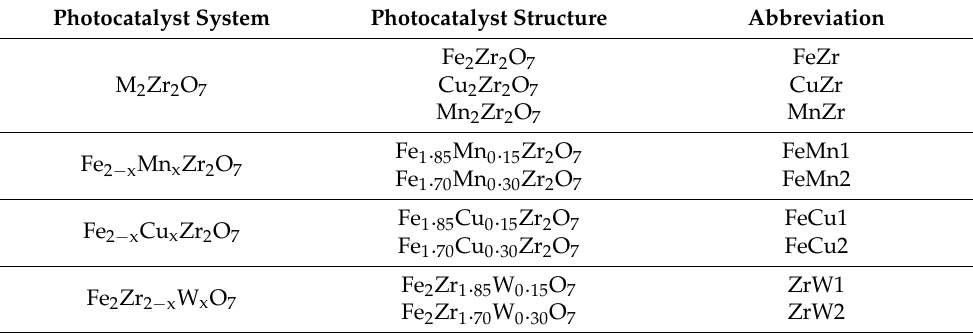
Table 1. The chemical structure and the abbreviation of the prepared nano photocatalysts.